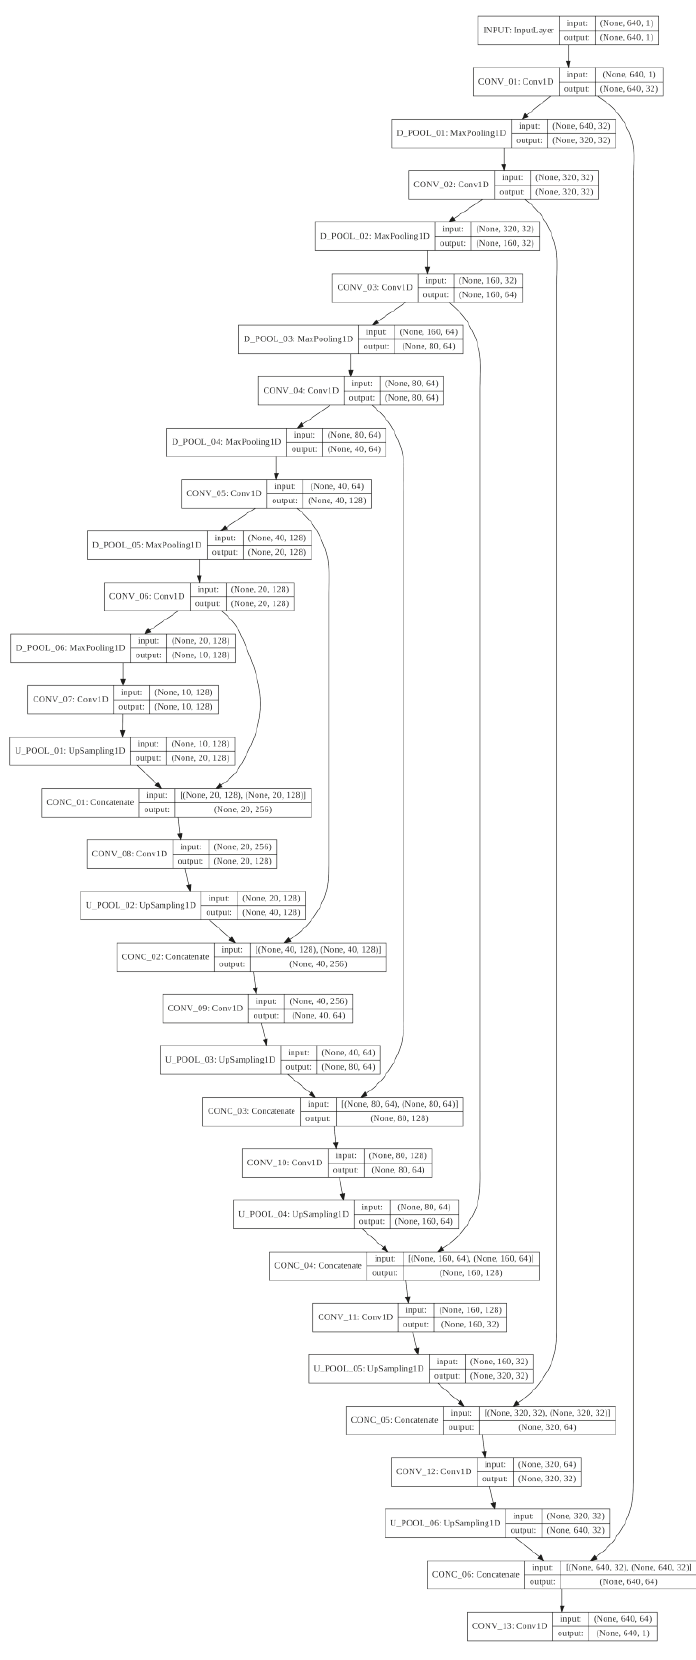
Figure A2. U-Net based deep convolution autoencoder (UDCAE)